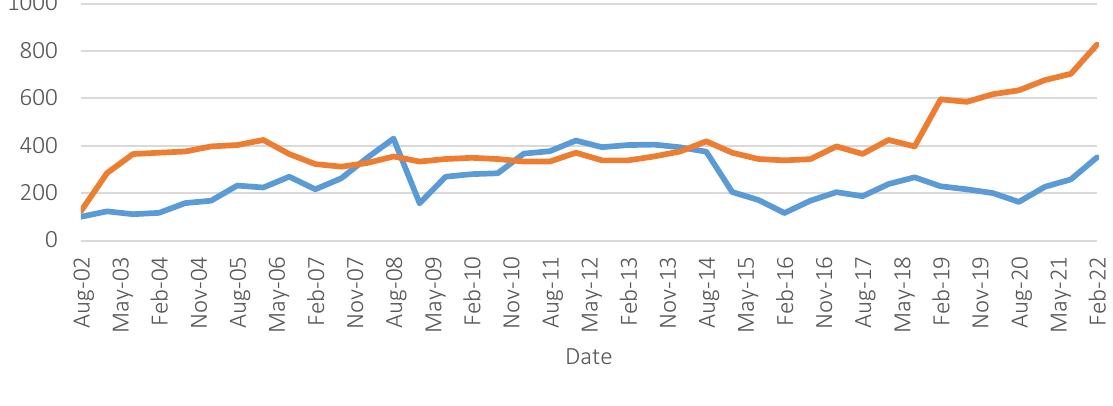
Figure 1. Saudi Arabia’s crude oil price and financial market performance correlation